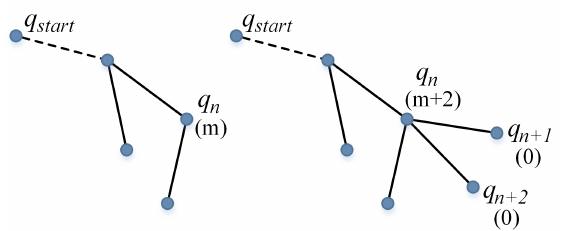
Figure 2. The change strategy of node state value δ in the node control mechanism. q start is the initial node, and q n is any node in the tree. q n + 1 and q n + 2 are child nodes of q n . The values in parentheses are the node state values δ we recorded.